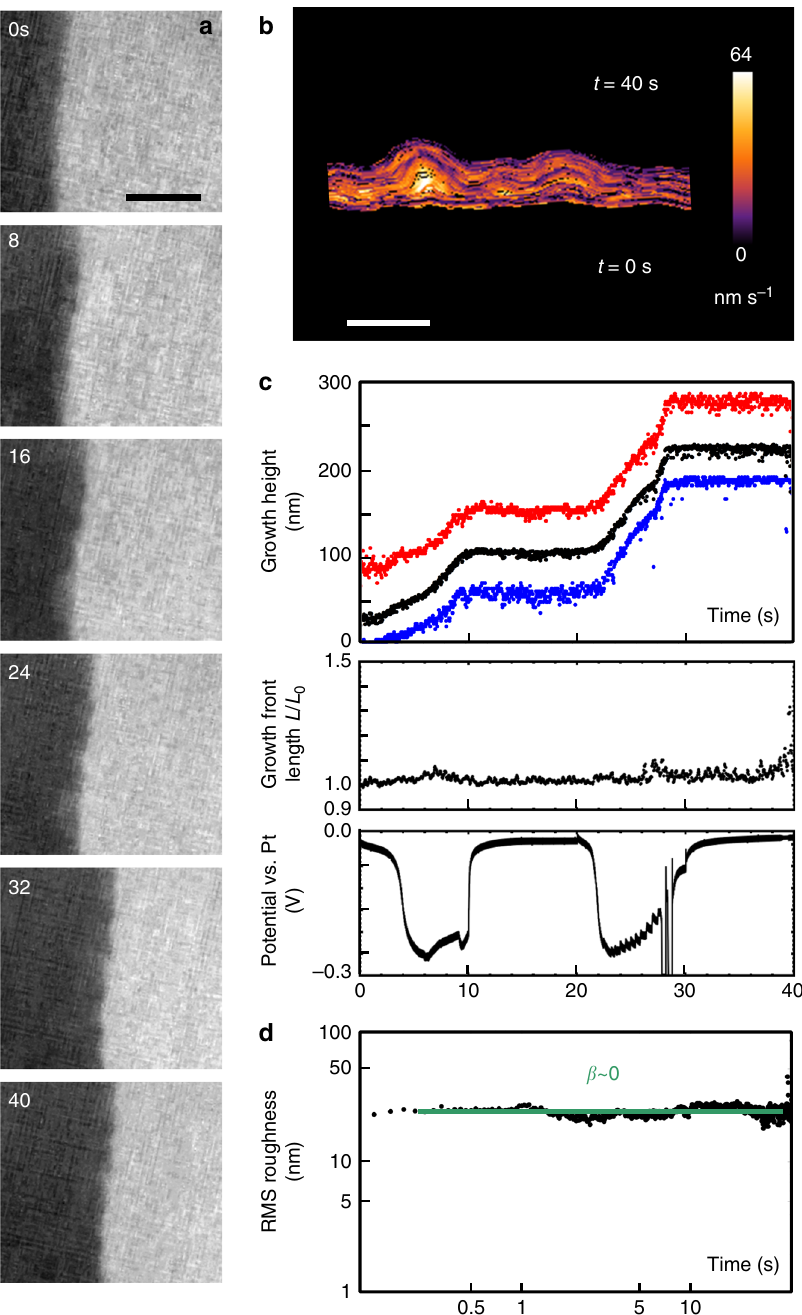
Fig. 5 Electrochemical deposition of Cu in the presence of an additive. a Images recorded in bright- fi eld conditions extracted from Supplementary Movie M6. Deposition took place in the same electrolyte of Fig. 1, but with saturated PbSO 4 . A total of 300 nA was applied for 10 s, 0 nA for 10 s, and then repeated. Times are shown in seconds since current fl ow began. Scale bar 300 nm. b Interface position from movie frames, color coded by normal growth speed. Scale bar 200 nm. c Structural and electrical data as a function of time: growth height (black = average; red = maximum; and blue = minimum), total length of growth front, and potential. The average growth rate in the pulses is 14 nm s − 1 and zero between pulses. This is equivalent to 380 A m − 2 in the pulses. d RMS roughness of the growth interface shown as a log – log plot. The best- fi tting straight line and exponent are